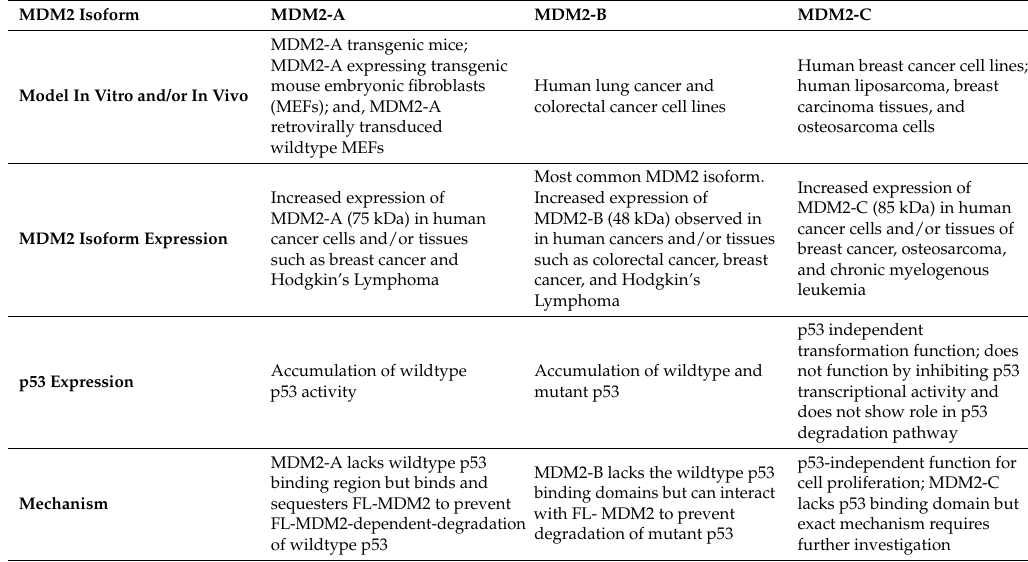
Table 1. Presence of MDM2 isoforms and p53 status